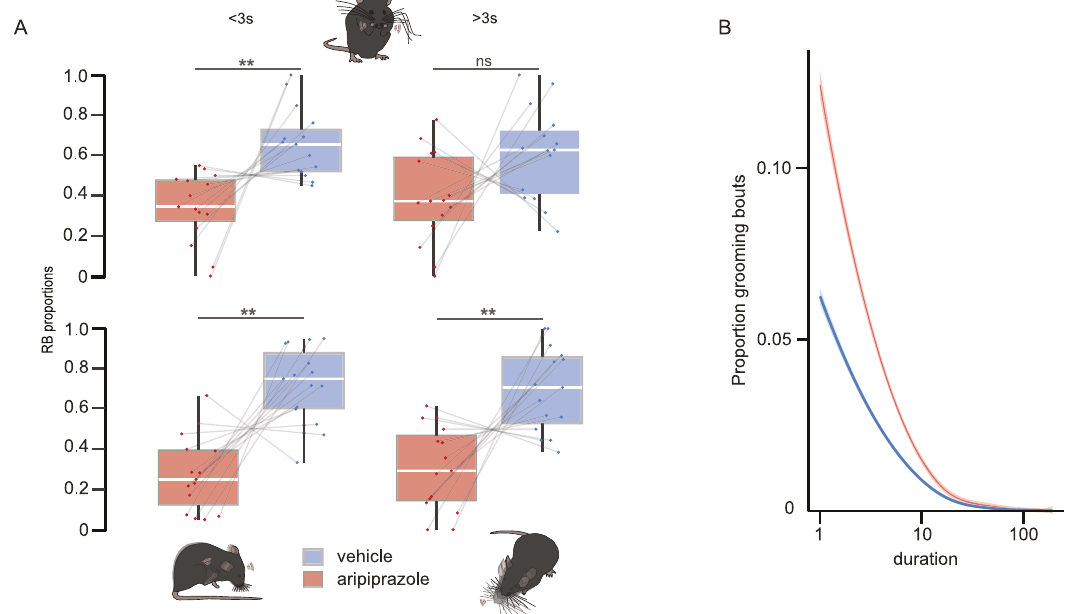
Fig. 5 Short grooming bouts, head/body twitches and scratching were reduced by aripiprazole. A Acute treatment with aripiprazole (1.5 mg/kg) signi fi cantly reduced the number of single-phase grooming, head/body twitches and scratching (Wilcoxon signed-rank test: all p < 0.01; non-parametric, paired permutation test: all p < 0.01), but not the number of syntactic grooming events (Wilcoxon signed-rank test: p = 0.08 and non-parametric, paired permutation test: p = 0.09). Plotted are the proportions of number of RB events under aripiprazole treatment and the sum of the number of RB events (vehicle + aripiprazole) of individual mice. B Aripiprazole in particular shorter grooming events in Sapap3 − / − mice. The x -axis is depicted on a log 10 scale. Box whisker plots were designed as described in the legend of Fig. 2. Vehicle and aripiprazole conditions are colour-coded in blue and red, respectively. * p < 0.05, ** p < 0.01, ns non-signi fi